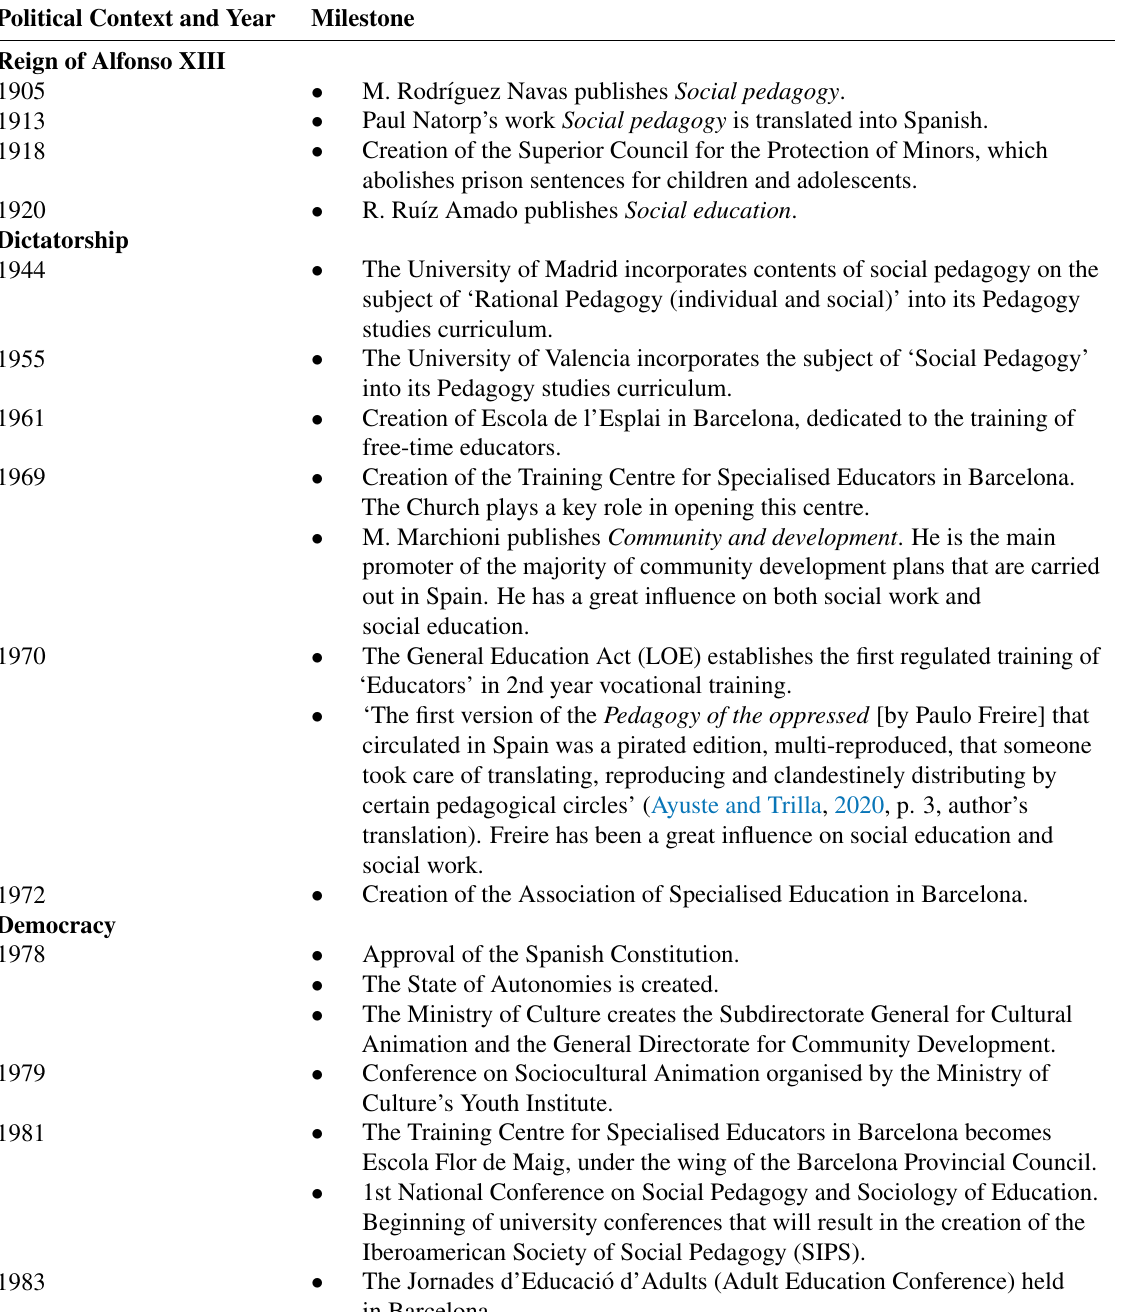
Table 2. Milestones in the history of social pedagogy and social education in Spain (Source: Author,